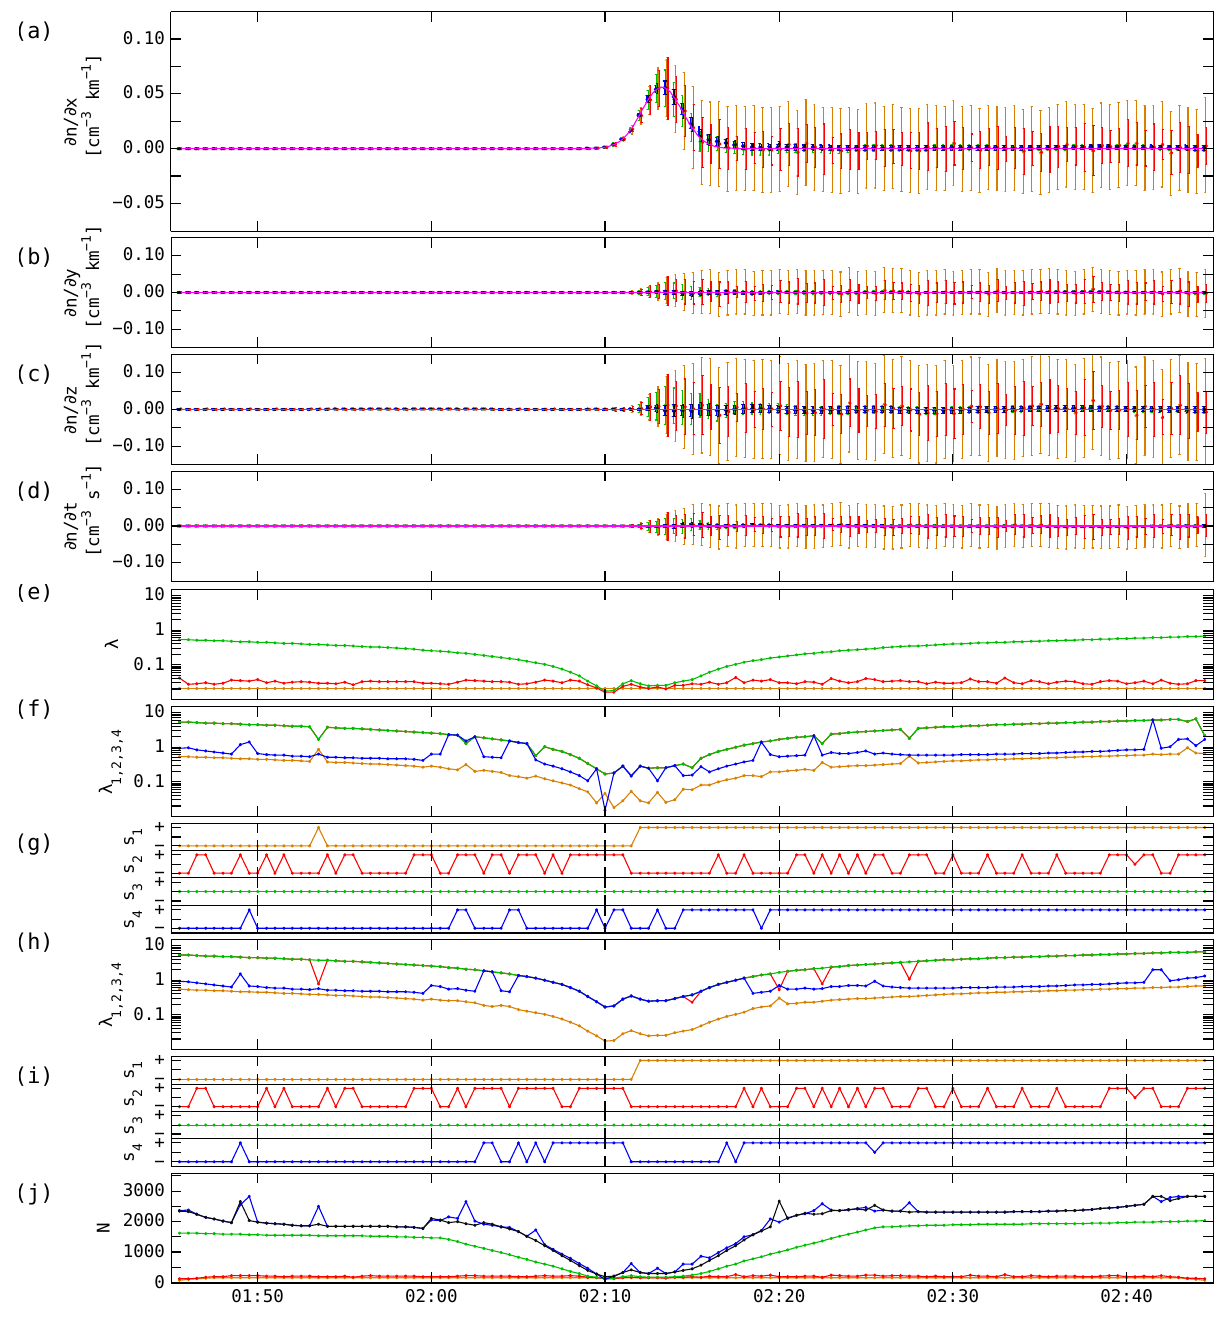
Fig. 6. Least-squares gradient at a density interface (4 spacecraft, small separation, 5% error). Panels (a–d) show the x-, y-, z-, and t - derivatives obtained with automatic error estimation using global and local χ 2 optimization (orange and red), common rescaling (green), and direction-dependent rescaling with curvature (with λ 2 = λ 3 , blue, and the general case, black). Magenta lines indicate the exact gradient. All methods compute the gradients at the same instants; the data have been offset a little bit in time to improve visibility. (e) Relative homogeneity scale for global and local χ 2 optimization (orange and red), and for common rescaling (green). (f) and (g) Relative homogeneity scales and curvature signs for direction-dependent rescaling with curvature and λ 2 = λ 3 (orange: λ 1 , along x ; red: λ 2 , y ; green: λ 3 , z ; blue: λ 4 , t ). (h) and (i) Idem for the general direction-dependent case. (j) Number of equations (global and local χ 2 optimization: orange and red; common rescaling: green; direction-dependent rescaling with curvature: λ 2 = λ 3 , blue, and the general case, black).